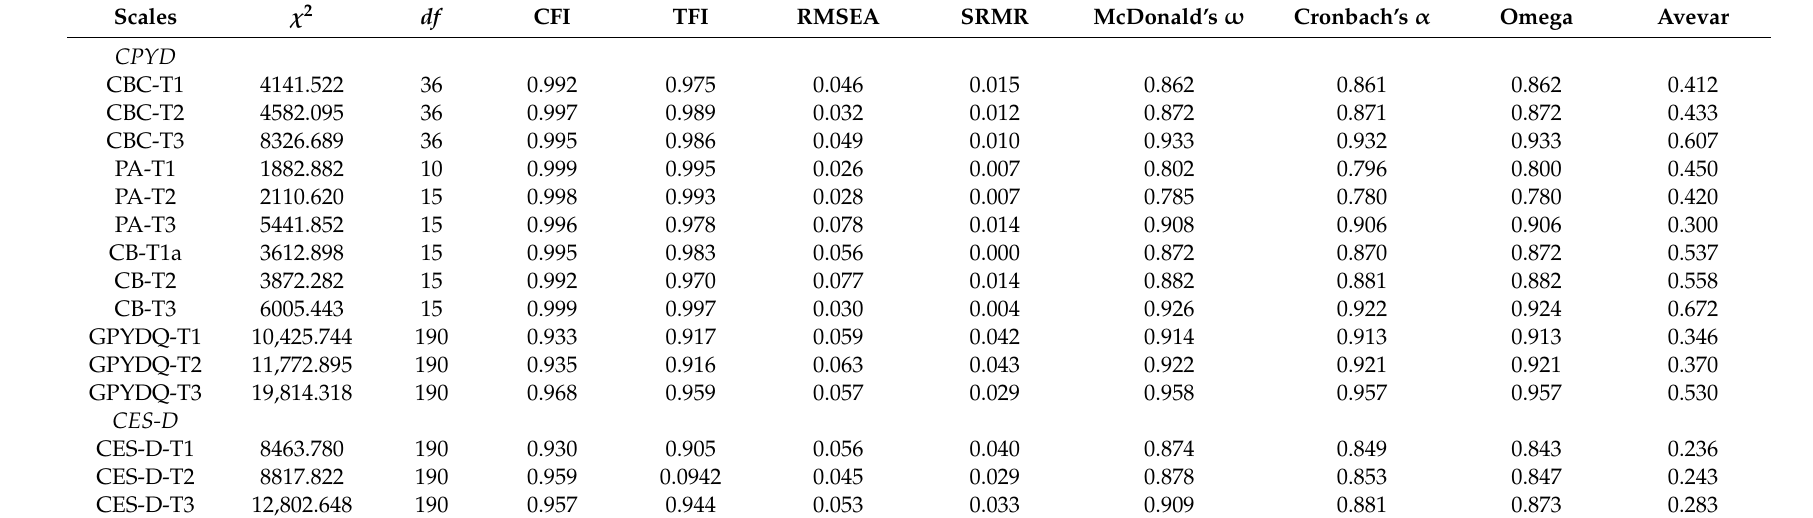
Table 1. Psychometric characteristics of CPYD and